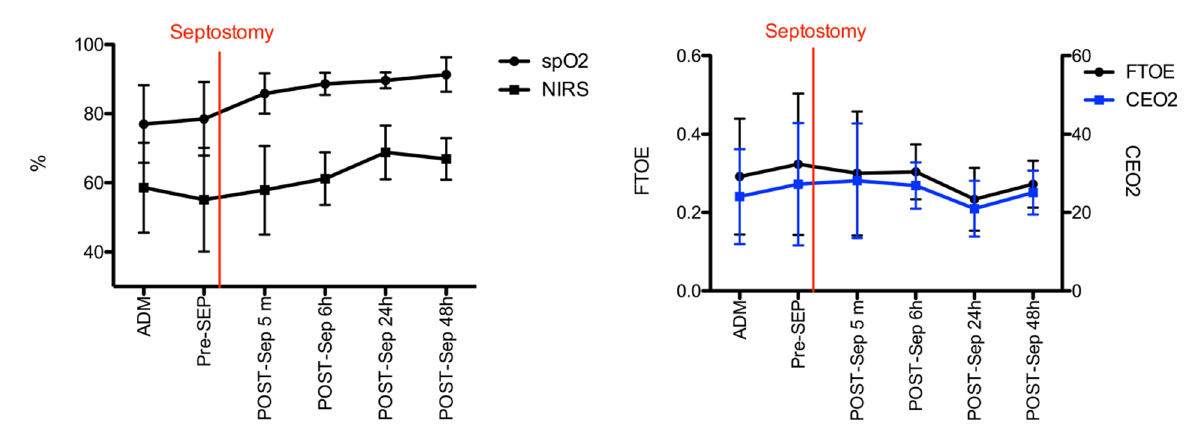
Figure 1. Evolution of SpO2, rcSO2 ( left ), FTOE, and CEO2 levels ( right ) before and after BAS. Black and blue lines and error bars are median and 25th and 75th percentile, respectively.